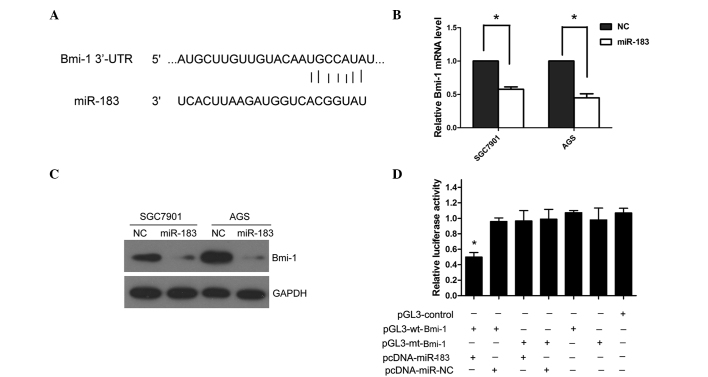
Bmi-1 is a direct target of miR-183 in gastric cancer cells. (A) The 3′-UTR of Bmi-1 mRNA contains the binding sequences of miR-183. (B) miR-183 overexpression significantly reduced the Bmi-1 mRNA levels in the SGC7901 and AGS cells. *P=0.027. (C) miR-183 overexpression also reduced the Bmi-1 protein levels in the SGC7901 and AGS cells. (D) Co-transfection with pcDNA-miR-183 and pGL3-wt-Bmi-1 reduced the luciferase activity in the 293T cells (*P=0.009), whereas co-transfection with pcDNA-miR-183 and pGL3-mt-Bmi-1 did not reduce the luciferase activity. *P=0.078. miR, microRNA; wt, wild-type; mt, mutant-type; 3′UTR, 3′-untranslated region; NC, negative control.